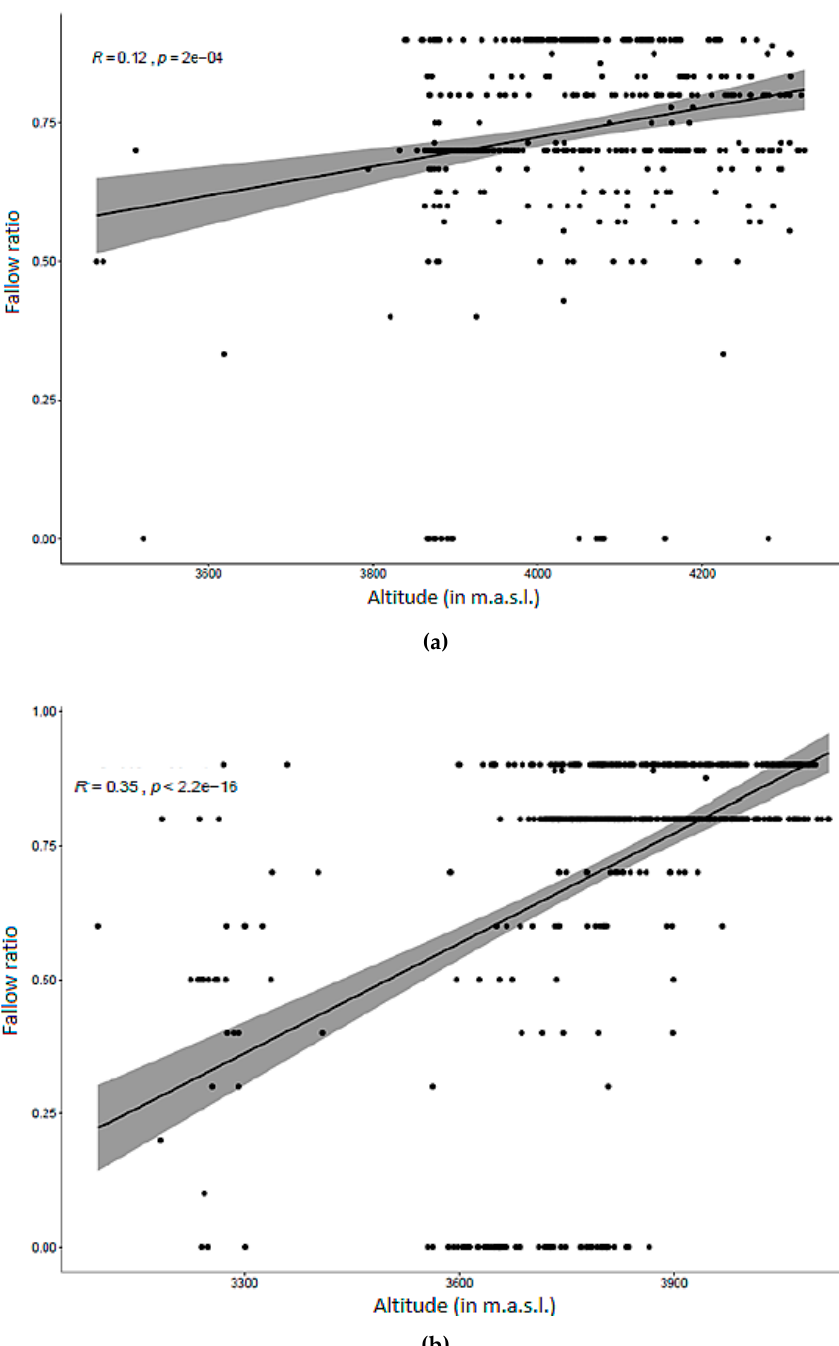
Figure 4. Significance of relationship between fallowing rate and altitude in the (a) Huancavelica and (b) Pasco landscapes.